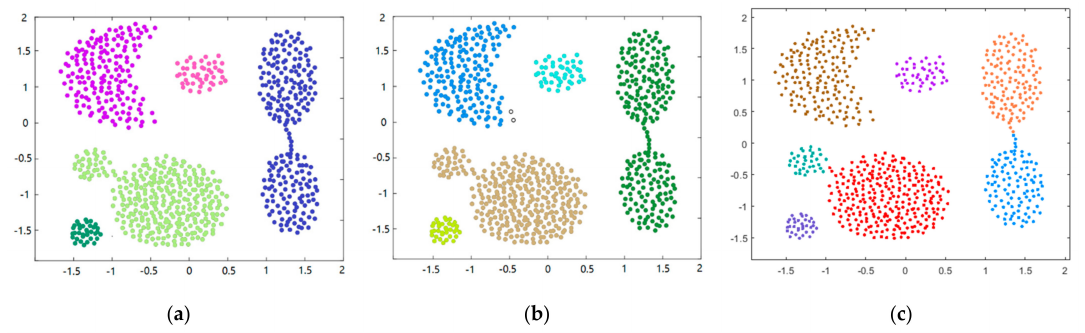
Figure 5. Comparison of clustering results on the Aggregation dataset: ( a ) DPC; ( b ) DBSCAN; ( c )